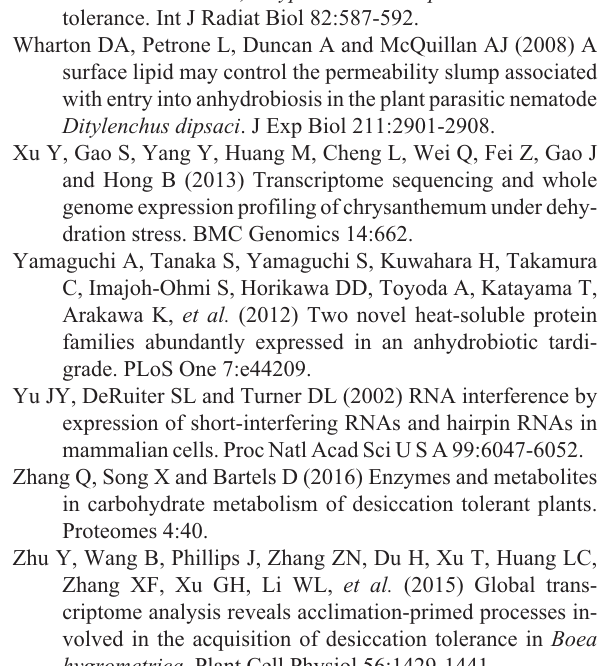
Table S1: Nucleotide sequences of primers. Table S2 : Nucleotide sequences of all dicer substrates. Figure S1: Staining P. superbus with erythrosin B and trypan blue. Figure S2: Gel